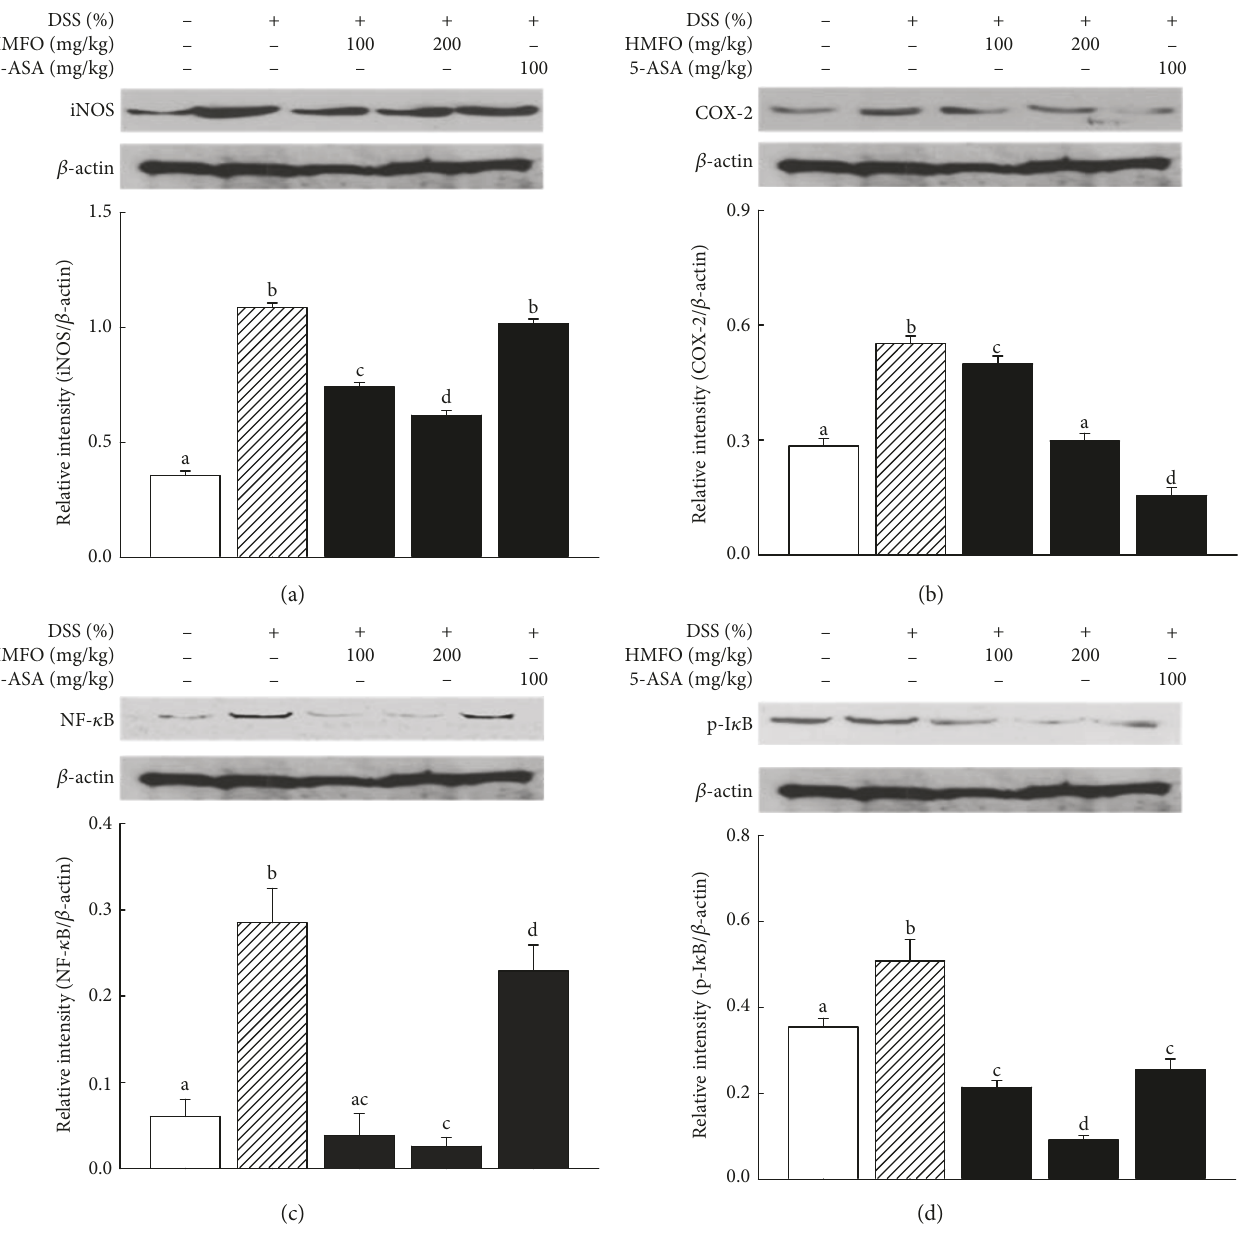
Figure 4: E ff ects of HMFO on iNOS, COX-2, NF- κ B, and p-I κ B protein expression in mice with DSS-induced colitis. Western blot analysis was used to determine (a) iNOS, (b) COX-2, (c) NF- κ B, and (d) p-I κ B levels in colonic tissues. The relative ratios of iNOS, COX-2, and the phosphorylated NF- κ B p65 subunit to β -actin were calculated using an image analyzer. Values with di ff erent letters are signi fi cantly di ff erent ( p < 0 05 ). 5-ASA, 5-aminosalicylic acid (100mg/kg); DSS, dextran sulfate sodium; HMFO, polysaccharides of Cynanchum wilfordii (100 or